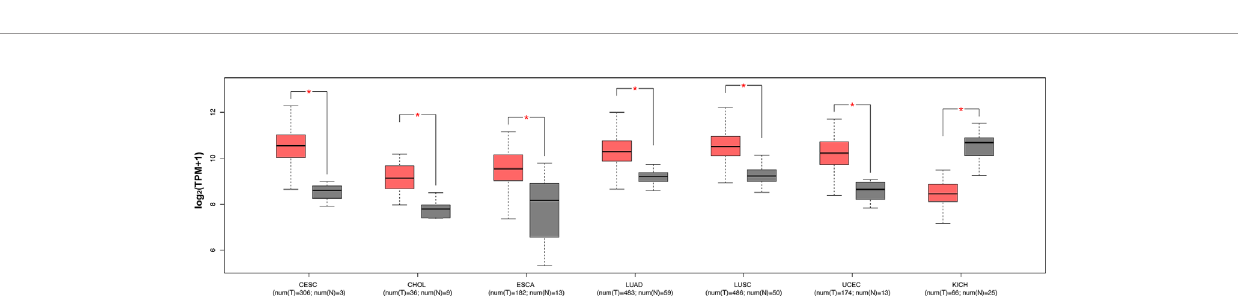
FIGURE 2 | ENO1 expression levels in seven types of cancers with signi fi cant differential expression of ENO1 between tumor and normal tissues. The expression levels of ENO1 are shown in transcripts per million. The log 2 FC cutoff and P cutoff were set as 1.00 and 0.01, respectively. Pink boxes represent tumor samples and gray boxes represent normal samples. The Y-axes of boxplots represent ENO1 expression in transcripts per million. Plots were generated using GEPIA with data from TCGA. num (T), number of tumor samples; num (N), number of normal samples.